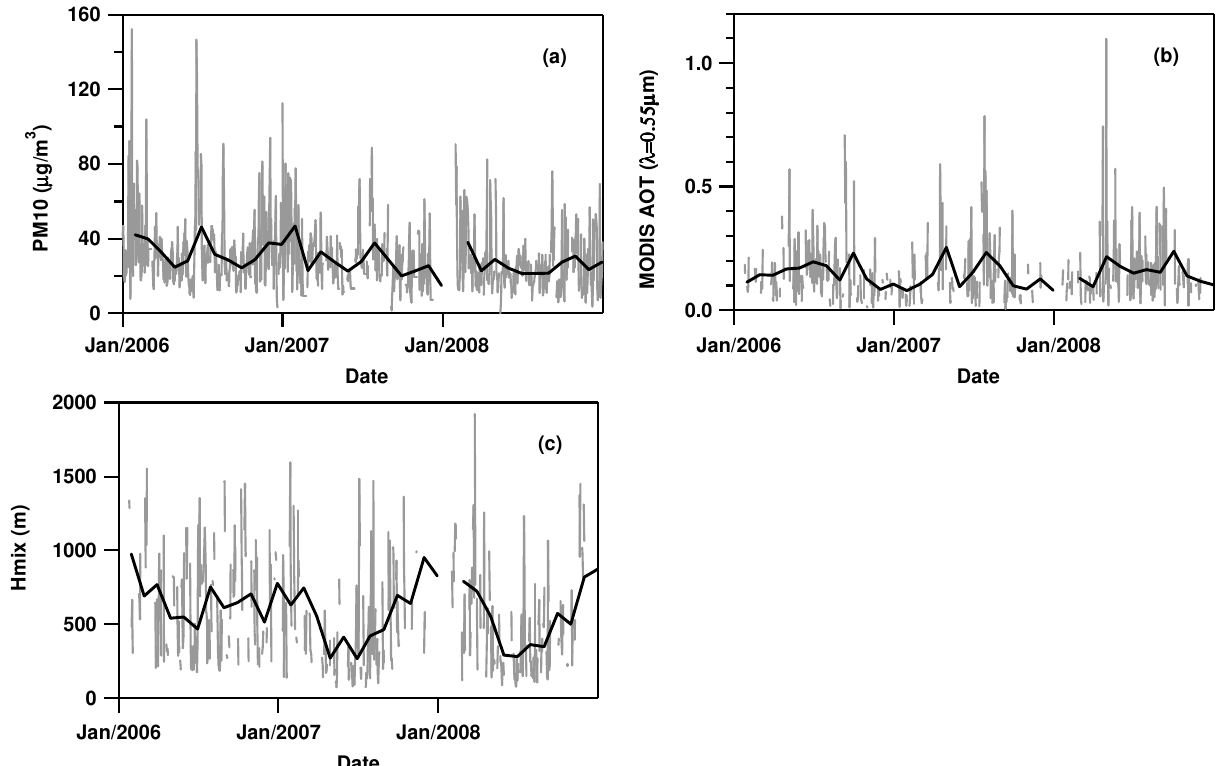
Figure 3. Time evolution of (a) PM10 mass concentrations, (b) MODIS aerosol optical thicknesses (AOT), and (c) mean mixing layer heights within 9–15 Universal Time (UT) time interval (Hmix), at Guagnano from 2006 to 2008. Grey lines show daily measurements, black lines show monthly means.